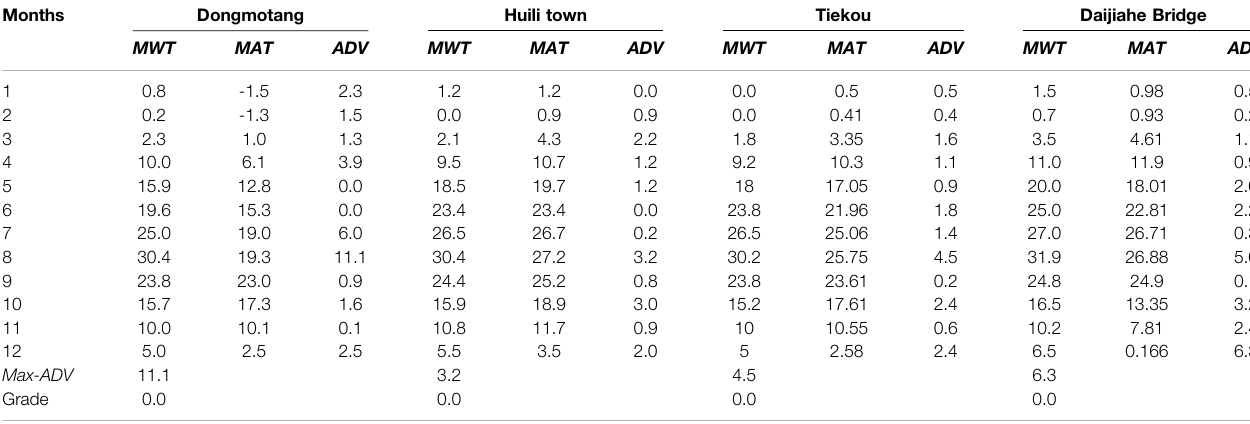
TABLE 5 | Results of water temperature variations ( ° C) and grading (Continuation). Months